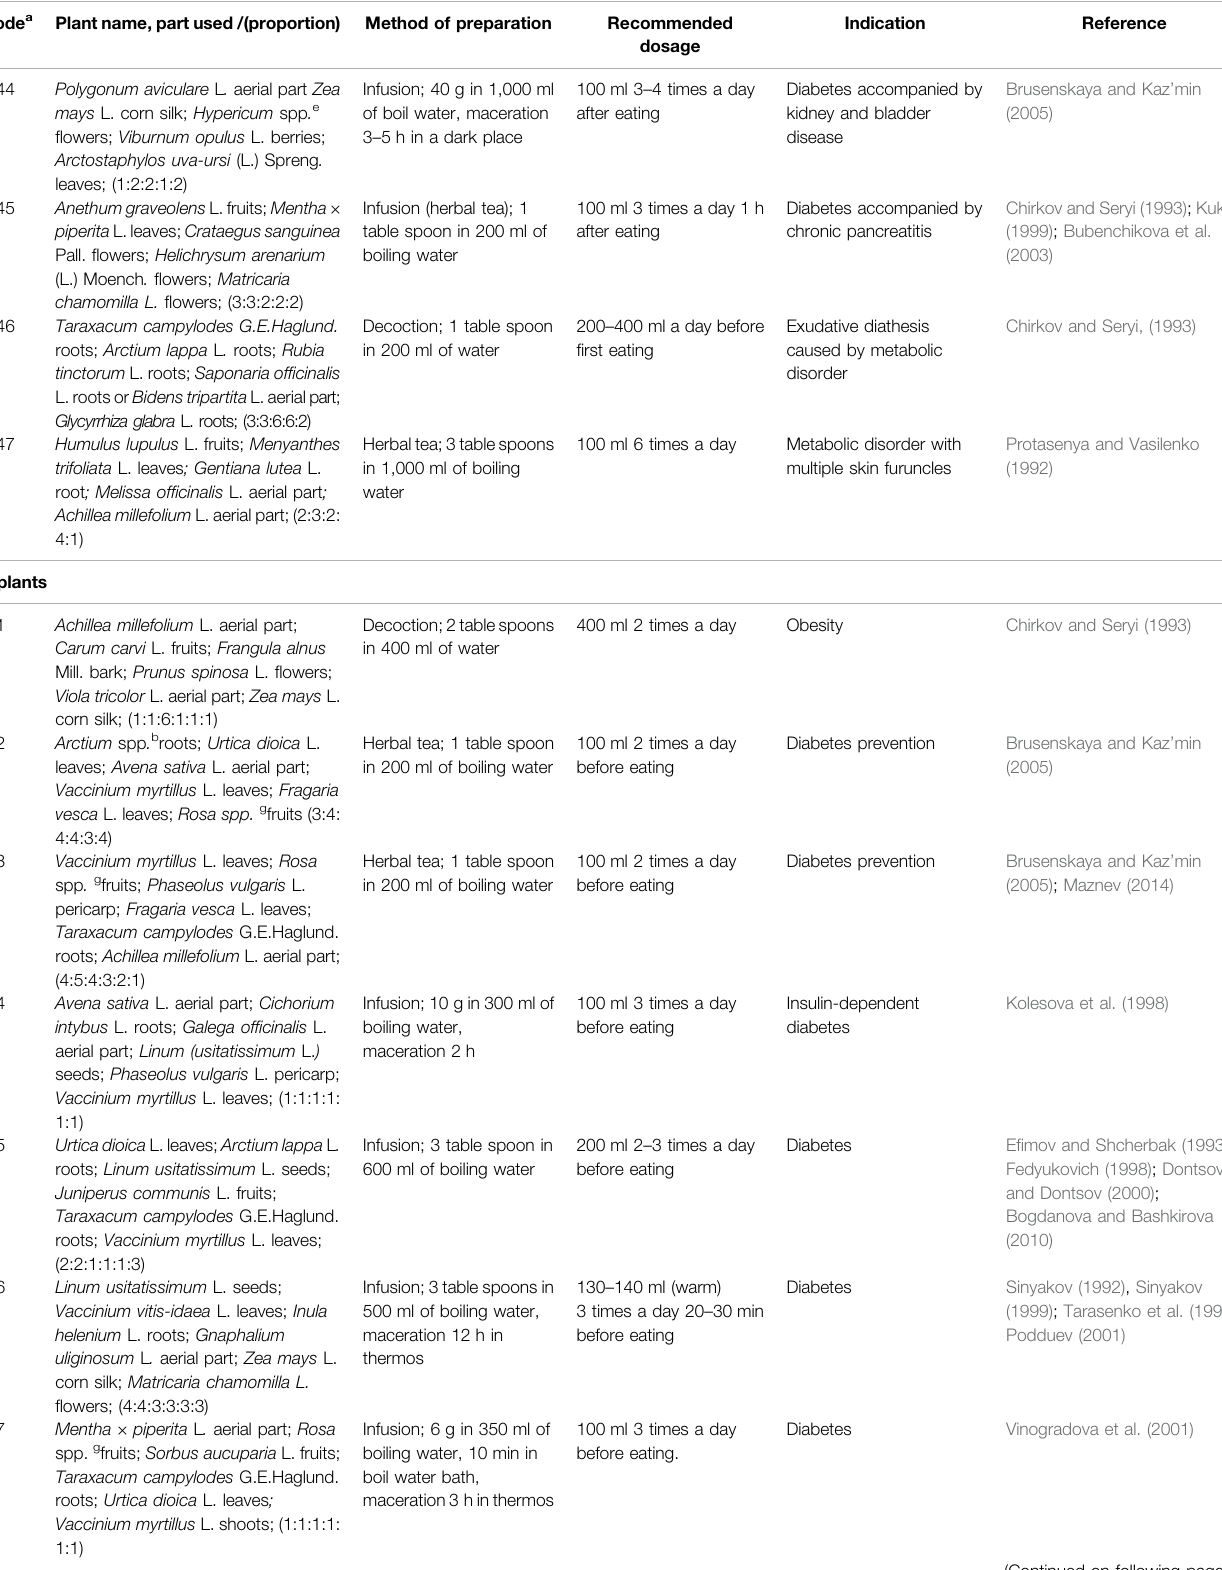
TABLE 1 | ( Continued ) The list of medical species used for the management of diabetes and related disorders in Russia. Code a Plant name, part used /(proportion) Method of preparation Recommended